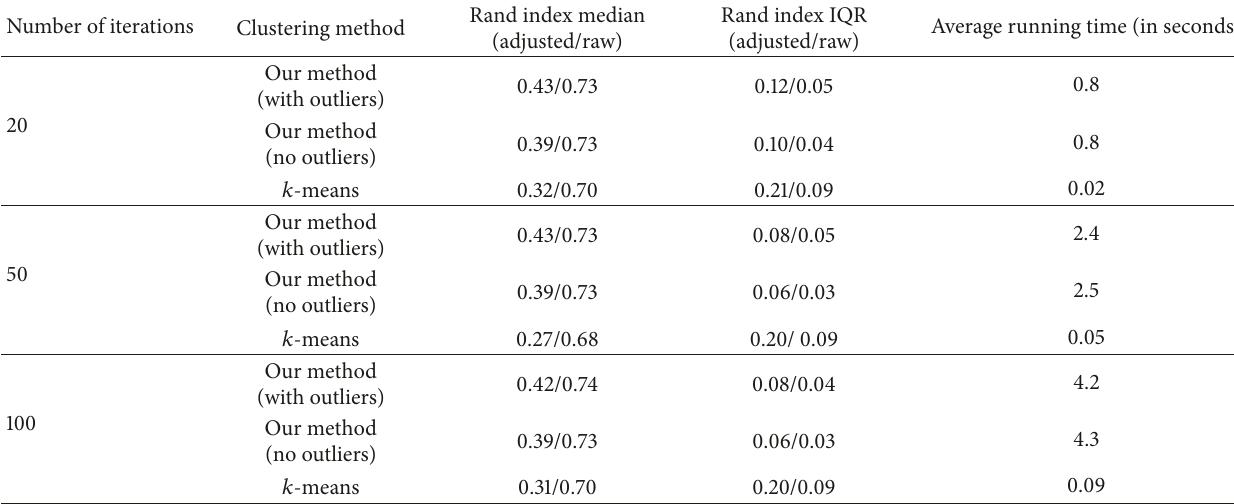
Table 4: Dependency of Rand index values and the running time for our and 𝑘 -means clustering methods on number of iterations performed (100 program runs for each value). Values of Rand index are presented in terms of medians and interquartile ranges (IQR). Number of